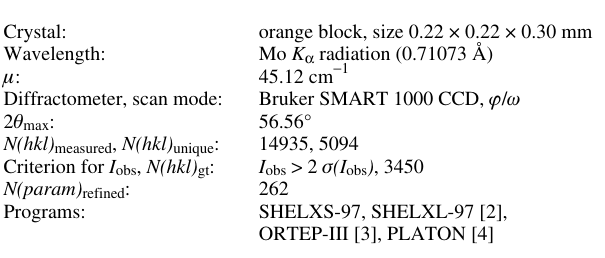
Table 1. Data collection and handling.